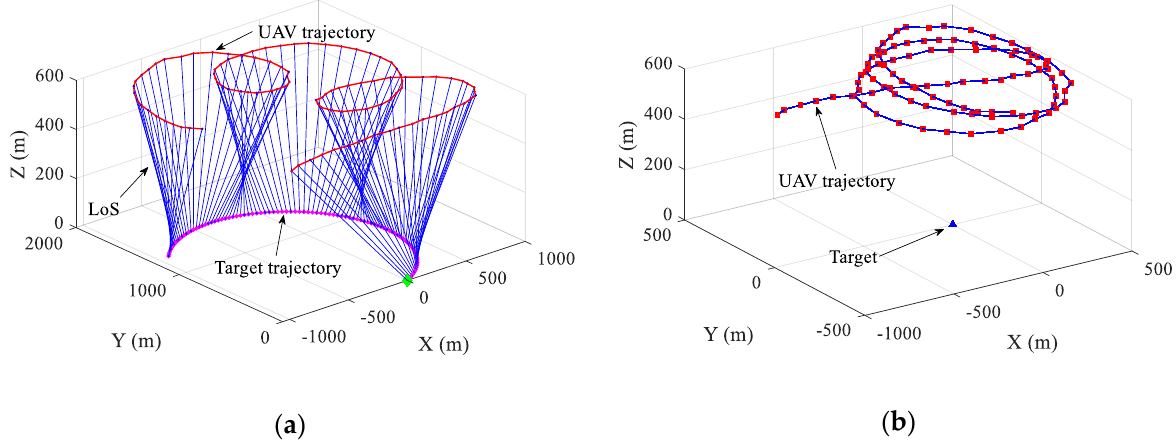
Figure 7. Trajectory optimization result with the constant turn model. ( a ) Absolute trajectory. ( b ) Relative trajectory with